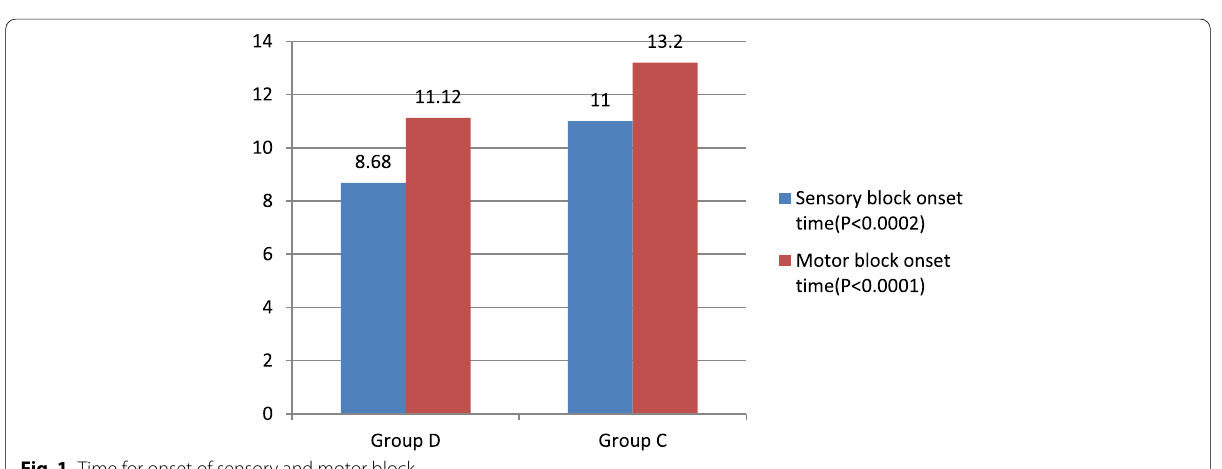
Fig. 1 Time for onset of sensory and motor